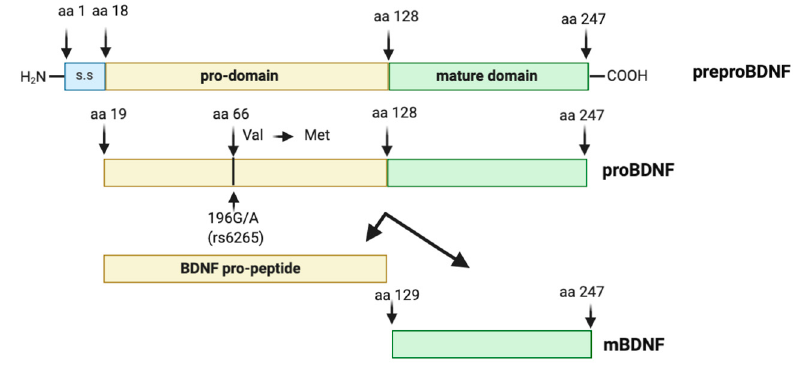
Figure 1. Brain-derived neurotrophic factor (BDNF) protein structure. The preproBDNF consists of three sequences: signal sequence (s.s), pro-domain, and mature domain. The intra- or extracellular cleavage of preproBDNF generates functionally active isoforms: BDNF pro-peptide and mature BDNF (mBDNF), each of which exhibits a characteristic affinity to a specific type of receptor. Arrowheads indicate known protease cleavage sites involved in the processing of mature BDNF. The position of the single nucleotide polymorphism (rs6265, Val66Met) and the substitution of valine (Val) in methionine (Met) at codon (aa) 66 in the human BDNF gene is indicated by an arrow.